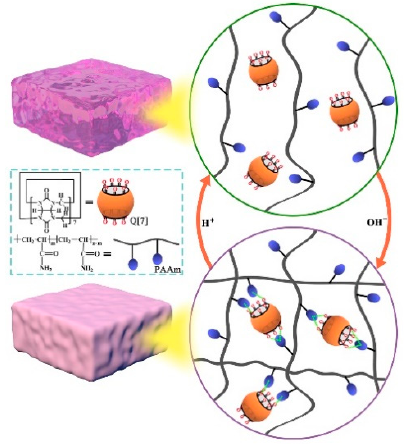
Figure 1. The sol–gel phase transition of Q[7]-PAAm gel.